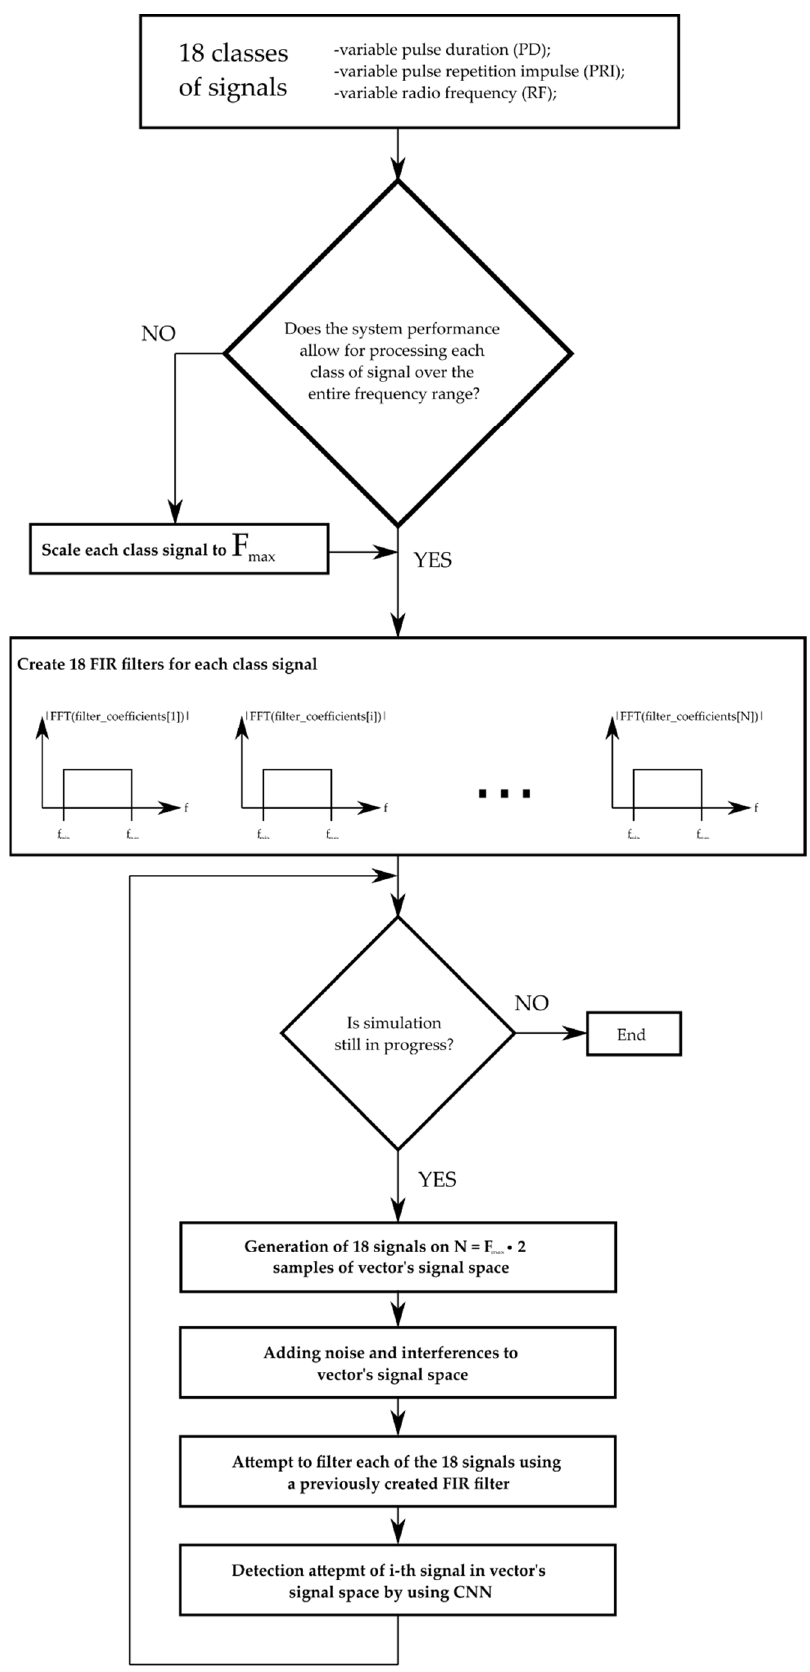
Figure 12. Diagram of the simulation and recognition of radar signals.